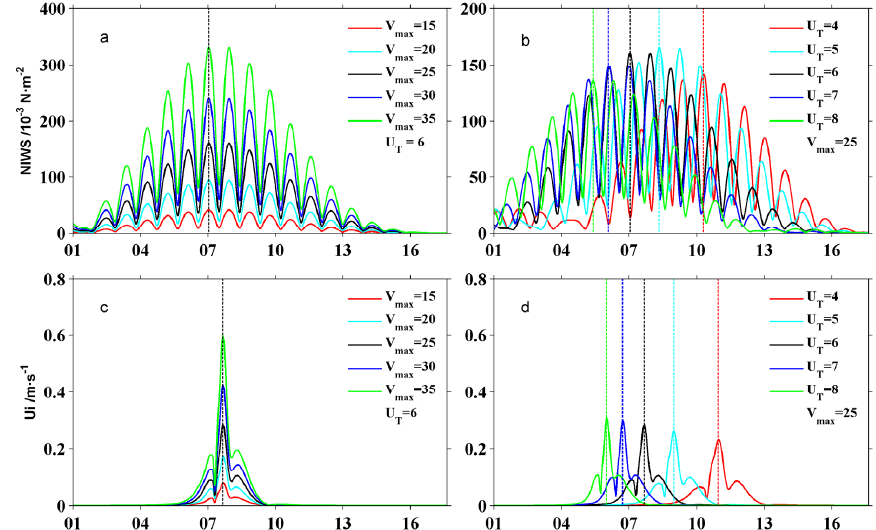
Figure 11. Time series (in days) of NIWS (unit 10 − 3 N/m 2 ) and oceanic near ‐ inertial currents U i (unit in m/s) in the mixed layer of fixed location B. ( a ) and ( c ) are the experiment results for the sensitivity of maximum wind speed ( V max ). ( b ) and ( d ) are the experiment results for the sensitivity of translation speed ( U T ).